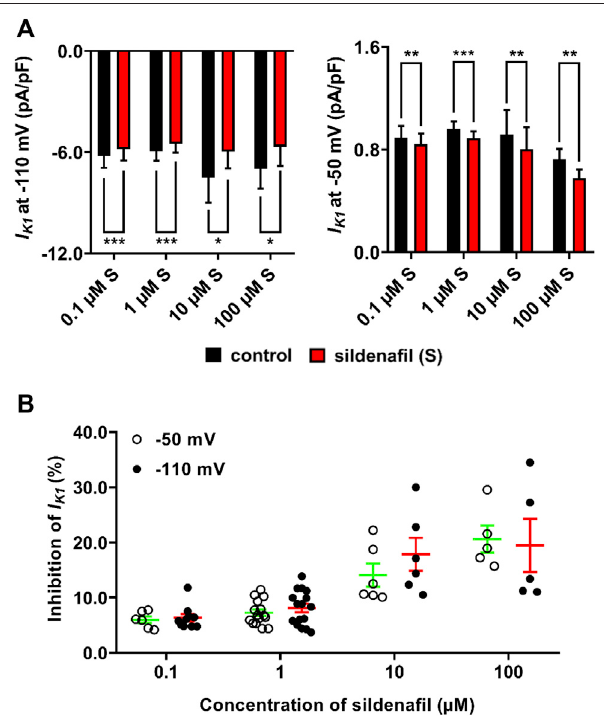
FIGURE 2 | Average effectsof sildena fi lon I K1 . (A) Average I K1 density in control and under the effect of sildena fi l between 0.1 and 100 μ M at − 110 mV (left graph) and − 50 mV (right graph); paired t -test, *, ** and *** — statistically K1 signi fi cant difference at p < 0.05, 0.01 and 0.001, respectively, (no signi fi cant differences among control values at the respective voltage). (B) Concentration dependence of the inhibition by sildena fi l was present at both − 50 mVand − 110mV;nosigni fi cantdifferencebetweeneffectsatbothtested voltages was